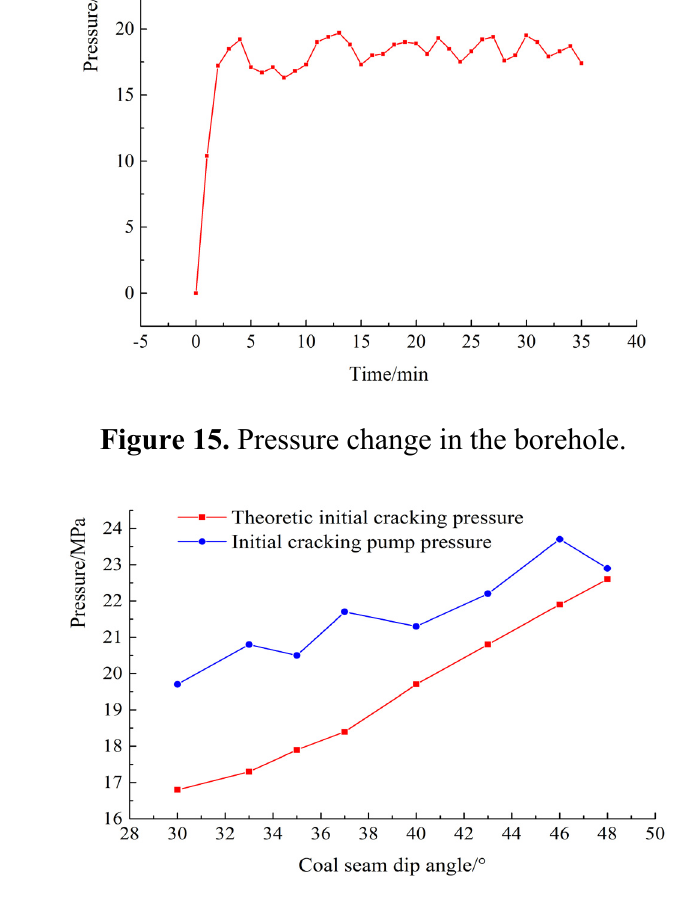
Figure 16. Comparison between the theoretic initial cracking pressure and the initial cracking pump